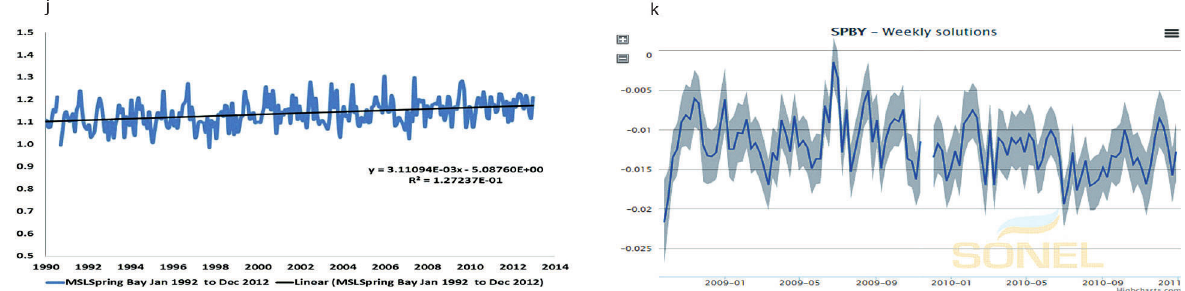
Fig. 1. Mean sea levels for different stations a, b, c: Monthly average mean sea levels, their fitting with a line and sines, and the resulting residual in Sydney. These graphs are repro - posed once more only because the climate scientists still fail to recognise that since the end of the 1800s the sea levels have been recorded by the tide gauges as naturally oscillating about a constant longer term trend of rise or fall with inter-annual and multi-decadal oscillation. Nor the line and sines fitting nor the measured data have accelerations d: Monthly average mean sea levels in Sydney over the short time window Jan 1992 to Dec 2012 e: Monthly average mean sea levels in Hobart and Spring bay as known in 2002 (Daly 2003a) f, g: Latest monthly average metric mean sea levels in Hobart and Spring bay h, i, j: Monthly average metric and RLR mean sea levels in Hobart and Spring bay over the short time window Jan 1992 to Dec 2012 k: vertical velocity of the GPS dome nearby the Spring bay tide gauges (SONEL, 2014). The information from the Tasmanian tide gauges of Hobart and Spring bay does not permit to infer any other conclusion if not Hobart has a relative rate of rise close to the one in Sydney while Spring bay may have a larger relative rate of rise because of more subsidence and other biasing issues increased after the start of the Austral- ian baseline Sea Level Monitoring